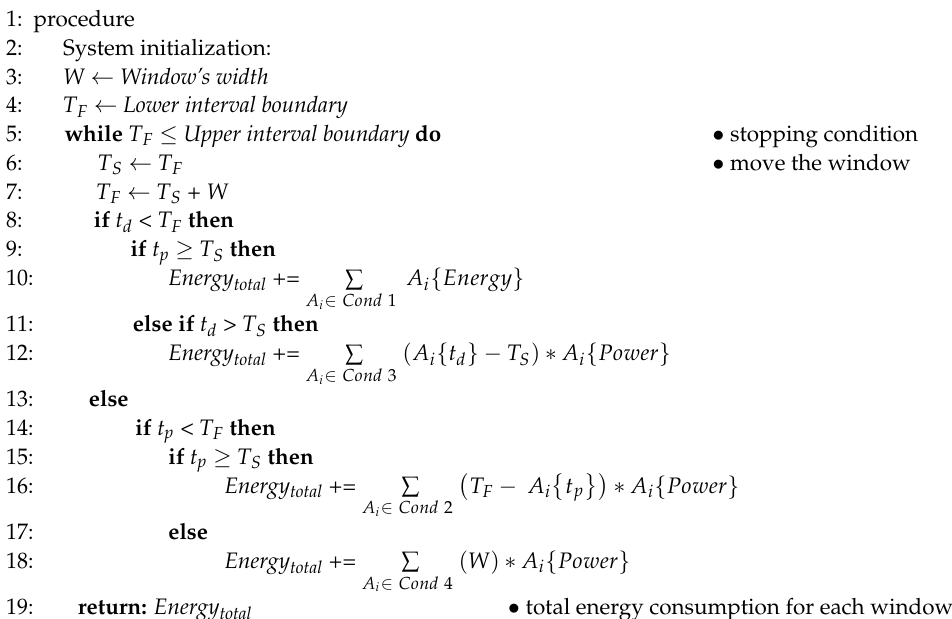
Algorithm 1: Calculating total energy consumption in tuned window width in the cov- eted time interval